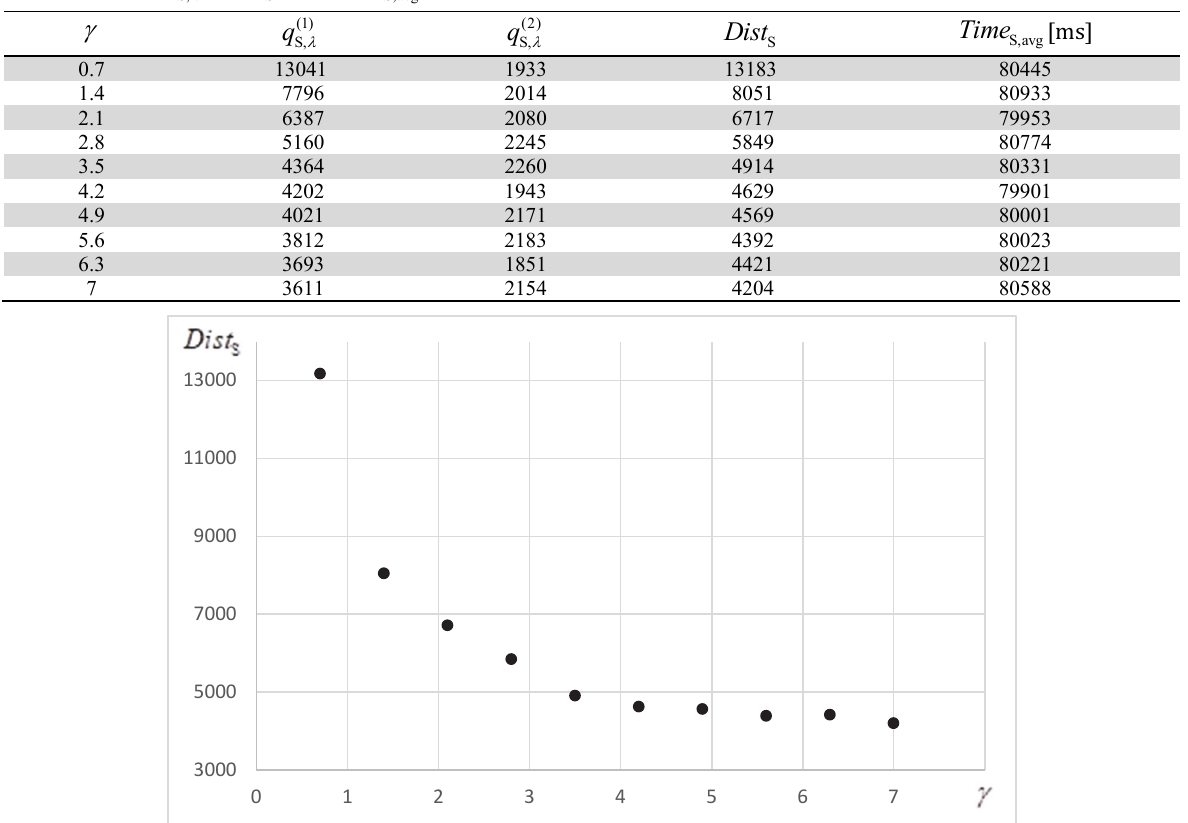
Time on  for n S,avg